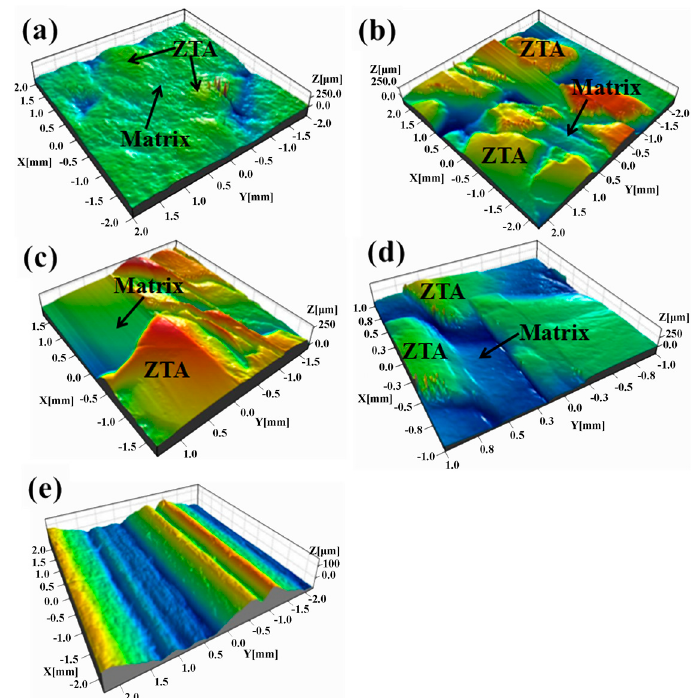
Figure 10. Three-dimensional colour micrographs of the worn surfaces of the composites under an applied load of 40 N in different abrasives: ( a ) SiC, ( b ) Al 2 O 3 , ( c ) SiO 2 , ( d ) Fe 2 O 3 , ( e ) HCCI in SiO 2 . Metals 2018 , 8 , x FOR PEER REVIEW